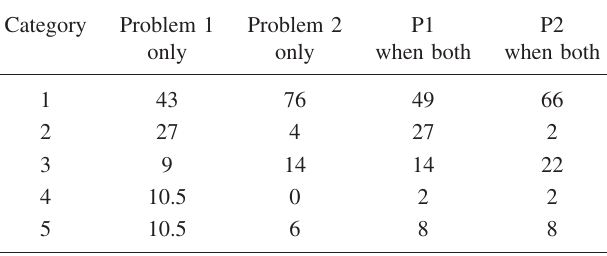
TABLE I. The percentage of students with responses in the five categories on the rotational and rolling motion problems. The sec- ond and third columns are distributions of responses when students solved only problem 1 and problem 2, respectively. The fourth and fifth columns are distributions of responses for problems 1 and 2, respectively, when the same students solved both